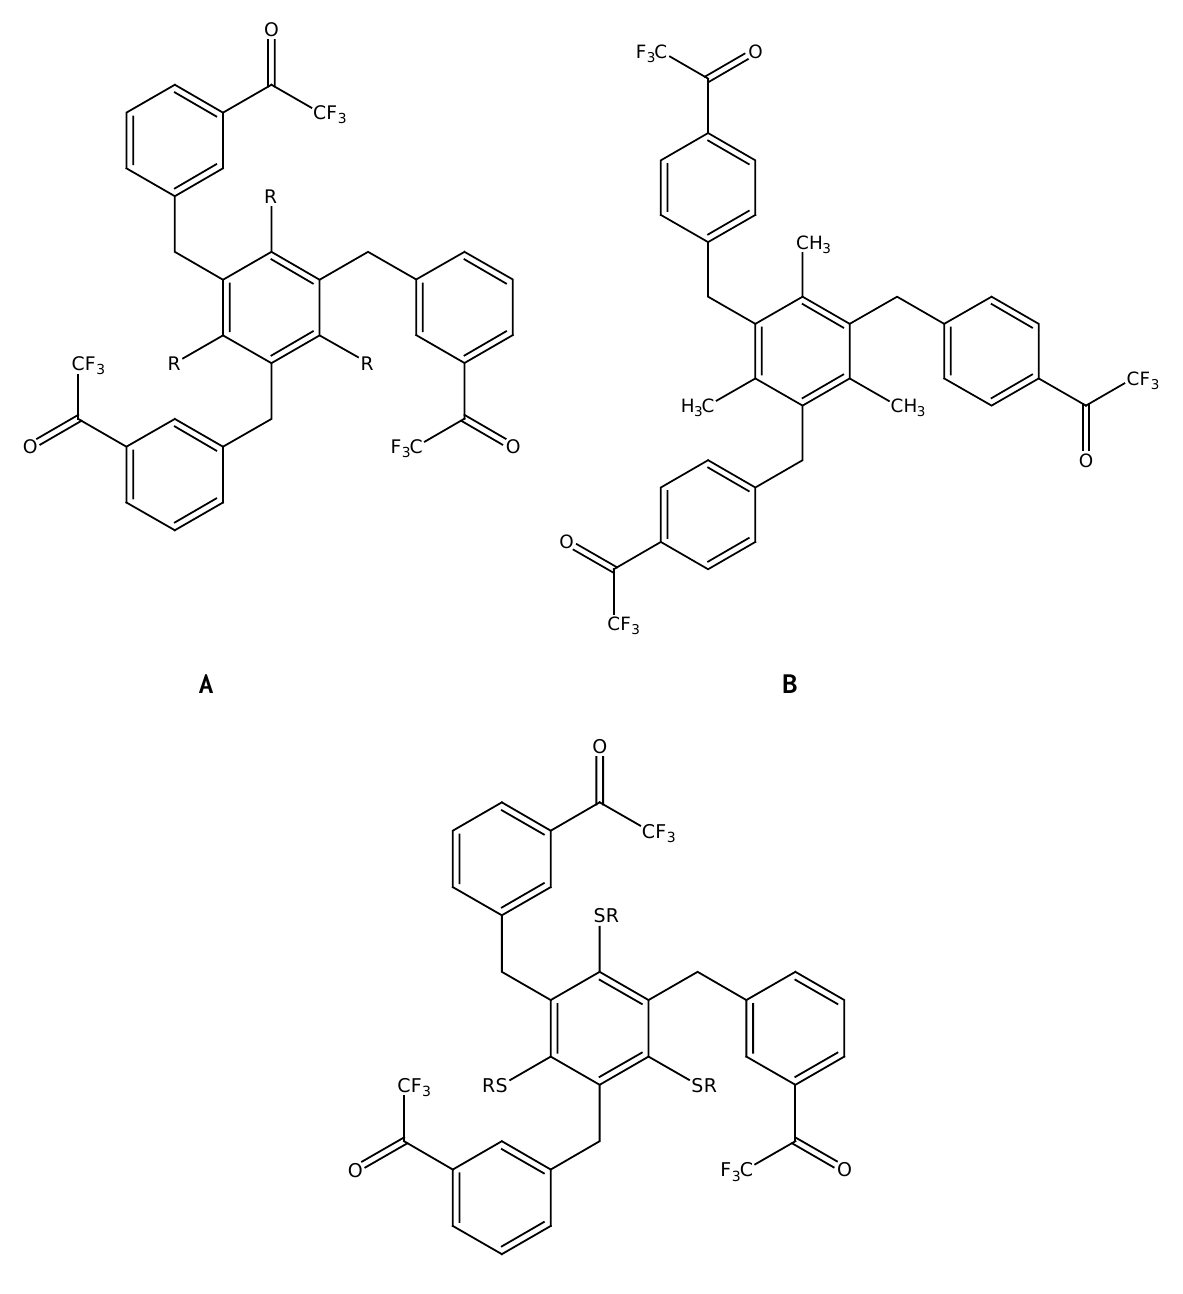
Figure 44. Tripodal trifluoroacetophenone